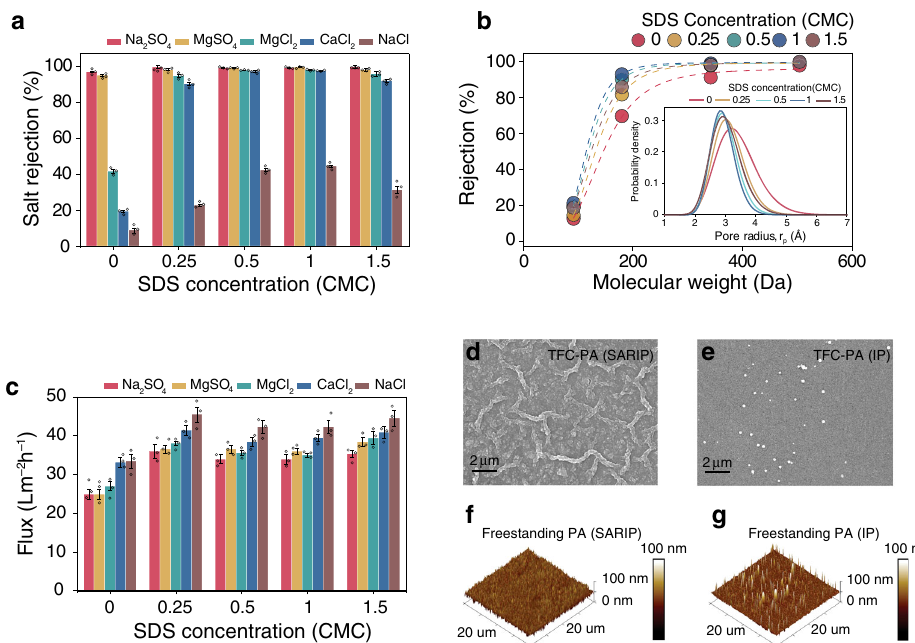
Fig. 4 Concentration-dependent performance and active layer morphology. a – c Impacts of SDS concentration on the performance and properties of the TFC-PA membranes, including a rejection of various salts; b rejection of uncharged model solutes including raf fi nose, sucrose, glucose, and glycerol. Inset: pore size distribution of PA active layers derived from rejection curves of uncharged solutes (Supplementary Table 20); and c water fl ux. The hydraulic pressure was 4 bar and the salt concentration in the feed solution was 1000 ppm. d , e SEM images of the surface of TCF-PA membranes obtained using SARIP and conventional IP performed on a PES support, respectively; f , g AFM topography of free-standing PA fi lms from SARIP and conventional IP, respectively. The free-standing fi lms were fabricated without support and then transferred to silicon wafers. The error bars represent the standard deviation of data from three replicate